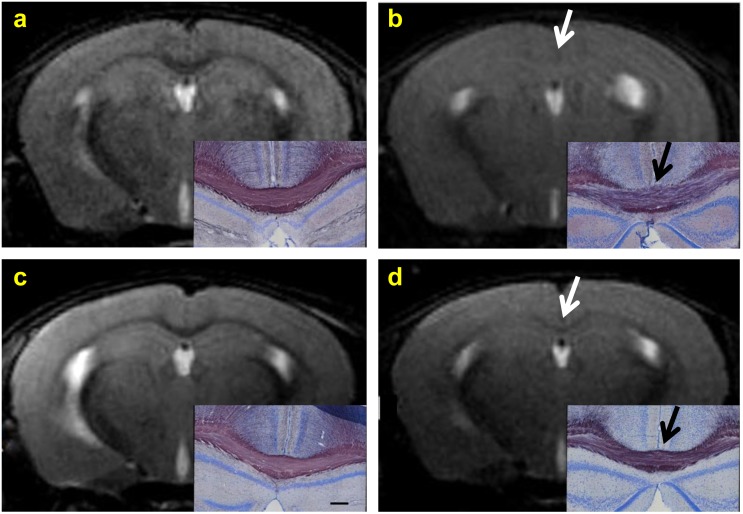
T2-w MRI Compared to BGII.T2-w RARE coronal images and pathologic sections stained with Black Gold II for myelin (insets, scale bar 200μm) from mice fed normal chow (a and c), after 6 weeks on cuprizone chow (b) and 6 weeks after stopping cuprizone chow (d). MRI from age-matched control mice (a and c) show low signal intensity in the corpus callosum and corresponding normal myelin on histology. After 6 weeks of cuprizone exposure (b), the corpus callosum has increased signal intensity (now isointense with cortex) and corresponding decreased staining for myelin on histology. Six weeks after being taken off of cuprizone, MRI shows return of hypointensity in the corpus callosum and corresponding increased staining for myelin on histology (d).